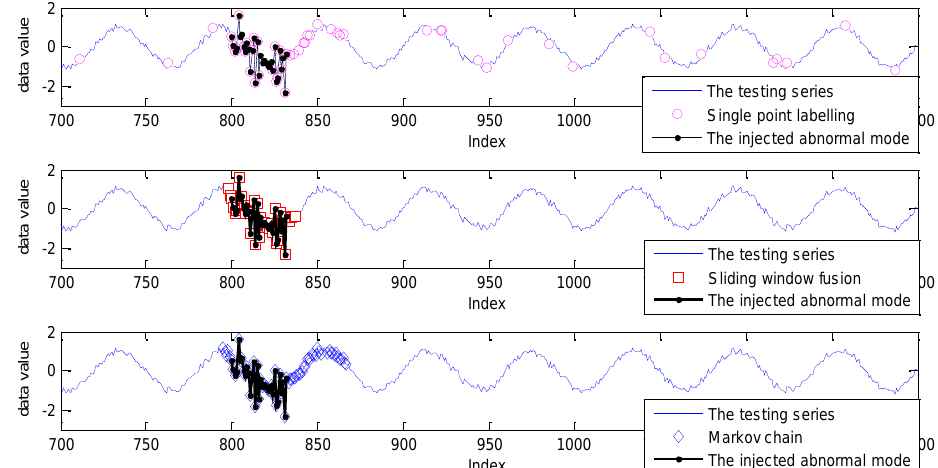
Figure 13. The detection results for the Ma Data based on the RVM model with three labelling strategies under the sliding window size of 10.